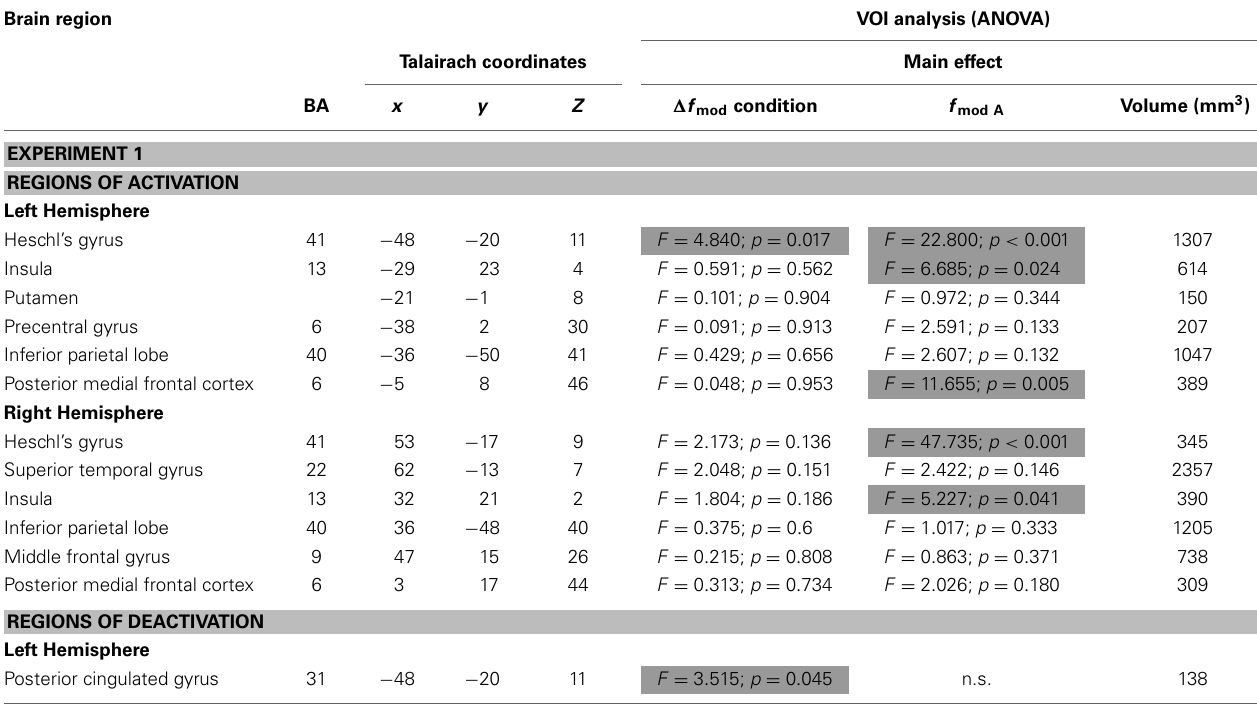
Table 2 | Brain regions (BA-Brodmann area; x,y,z -Talairach coordinates) showing positive or negative deflections of the BOLD signal in at least one of the three (cid:2) f mod conditions compared to the baseline ( t ≥ 4 . 5, p < 0 . 002) for each of the two f mod A (100, 300Hz) tested in Experiment 1 and the results of ANOVAs within the resulting